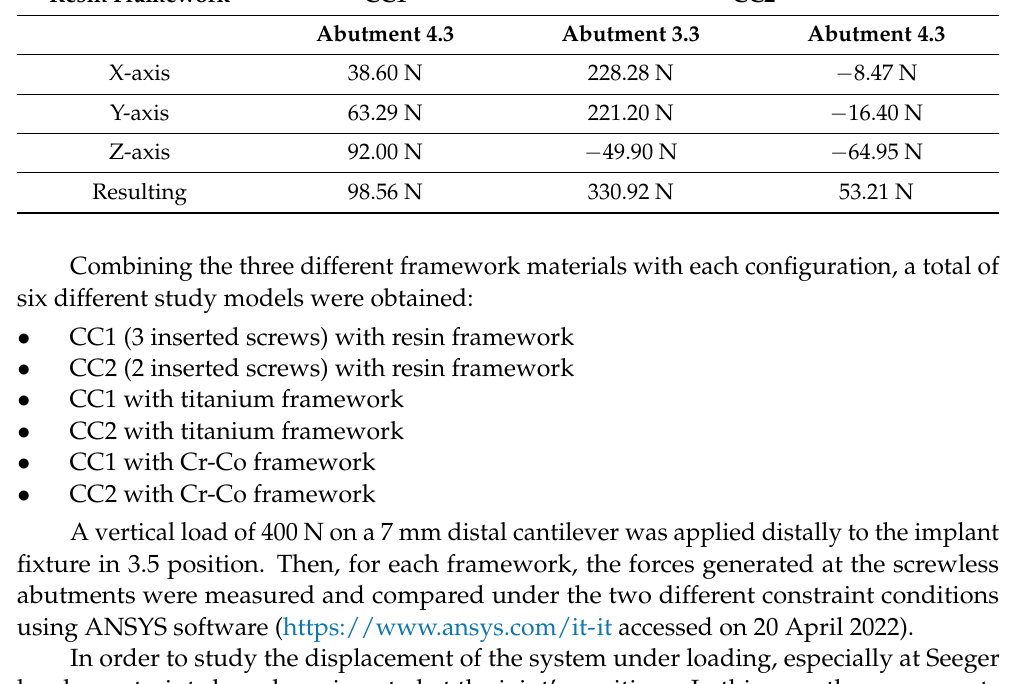
Table 1. Results of FEA evaluation for the resin framework in CC1 and CC2 R = resulting (reaction) force; X,Y,Z = (reaction) components of the resulting force; unit of measurement = reaction force (N). Resin Framework CC1 CC2